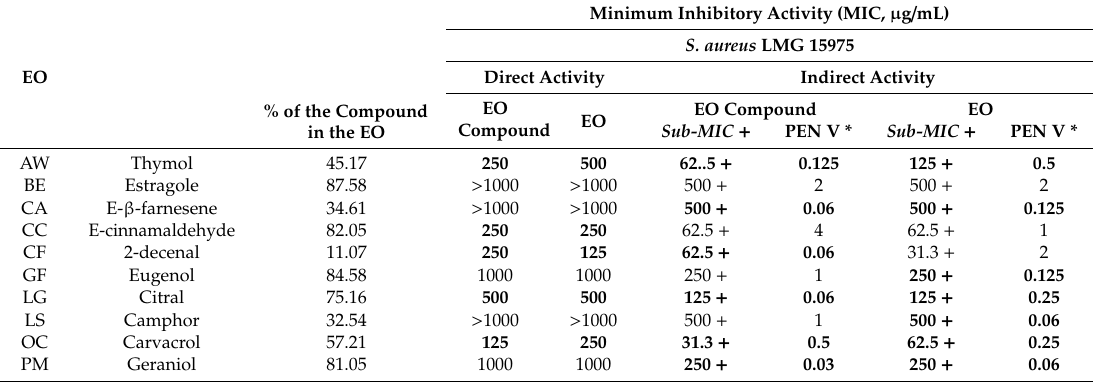
Table 8. Direct and indirect activity of the major compounds of the essential oils tested ( n = 3). In bold, the most promising